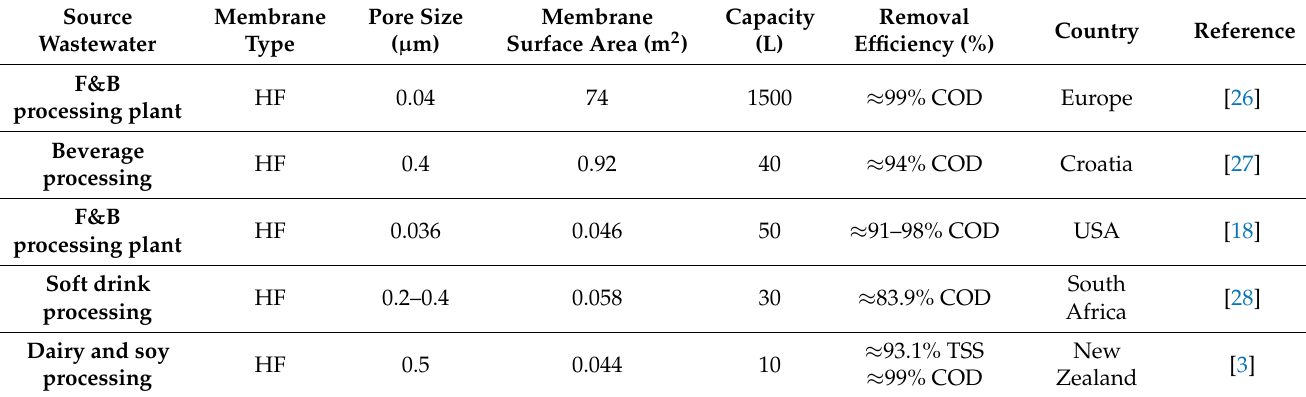
Table 1. The summary of MBR treatment for food and beverage industry